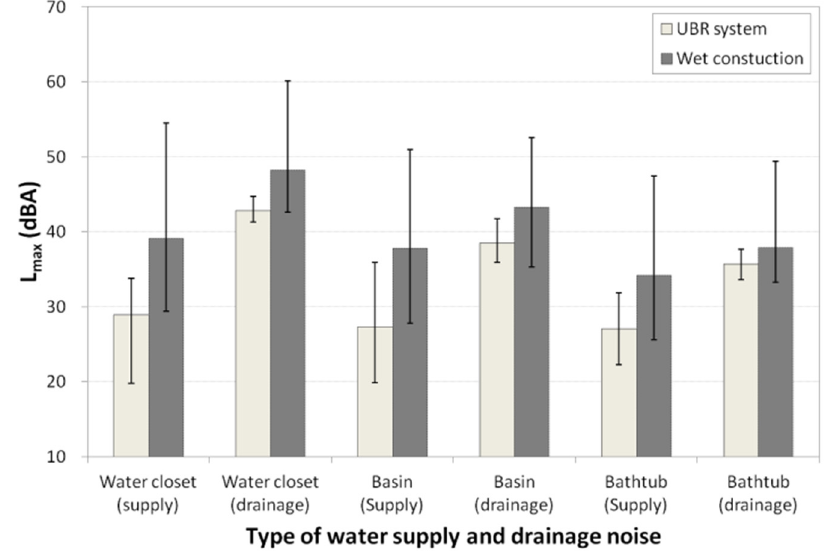
Figure 10. Average noise level for each sanitary ware according to the construction methods including the UBR system ( N = 15) and wet-construction method ( N = 97). The deviation bar indicates the range between the maximum and minimum noise levels measured in the different bathrooms.